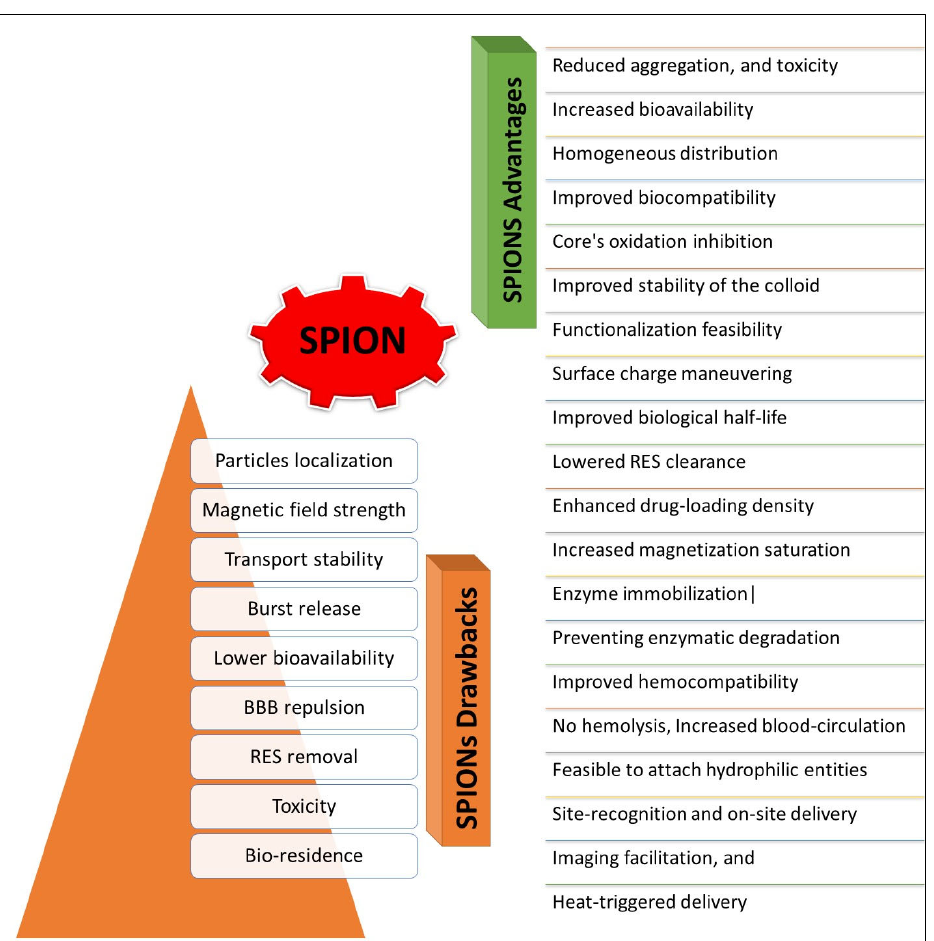
Figure 4. SPIONs’ advantages and shortcomings.